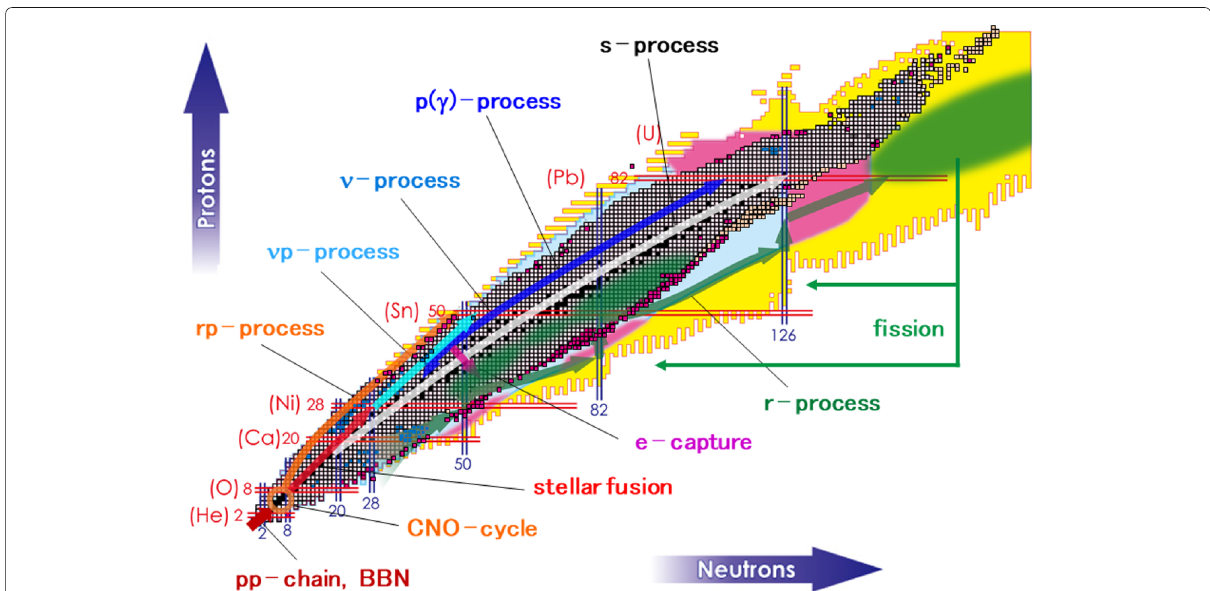
Fig. 1 Nuclear chart and the major nucleosynthetic processes in the universe. Most paths involve unstable nuclei, many of which are either difficult to be studied due to their short lifetimes and low beam intensities, or have not yet been discovered.. Two hundred twenty-six new isotopes (red boxes) have been synthesized and 84 nuclear masses (blue boxes) have been measured at Asian facilities and adopted in the Atomic Mass Evaluation by 2020 [1, 2]. The nuclei shown in purple-red and light blue indicate those with production rates higher than 1 particle per day, given a primary-beam intensity of 1 particle μ A at RIBF [3]. Isotopes in the yellow region are predicted based on the KTUY mass formula [4] but not synthesized yet. New facilities such as RAON and HIAF as well as the RIBF upgrade will provide new opportunities to synthesize more isotopes which are critical to the understanding of the nuclear processes in stars, galaxies, and the